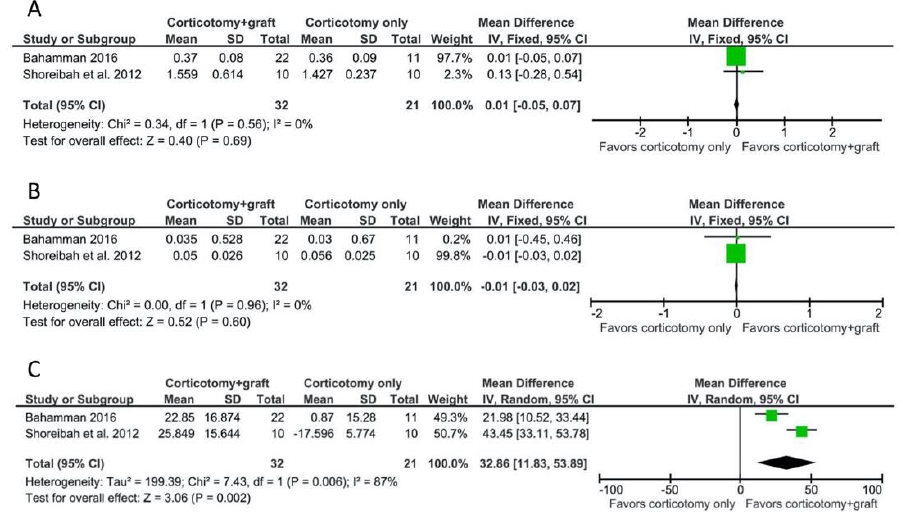
Figure 4. Meta-analyses for the outcomes of anterior CAOT compared to PAOO. ( A ) For pocket depth reduction, the WMD was 0.01 mm (95% CI = − 0.05–0.07 mm, p = 0.69), representing no statistically significant difference between the groups. ( B ) For root length reduction, the WMD was − 0.01 mm (95% CI = − 0.03–0.02 mm, p = 0.60), representing no statistically significant difference between the groups. ( C ) For the change of bone density, the WMD was 32.86 (95% CI = 11.83–53.89, p = 0.002), favoring the PAOO